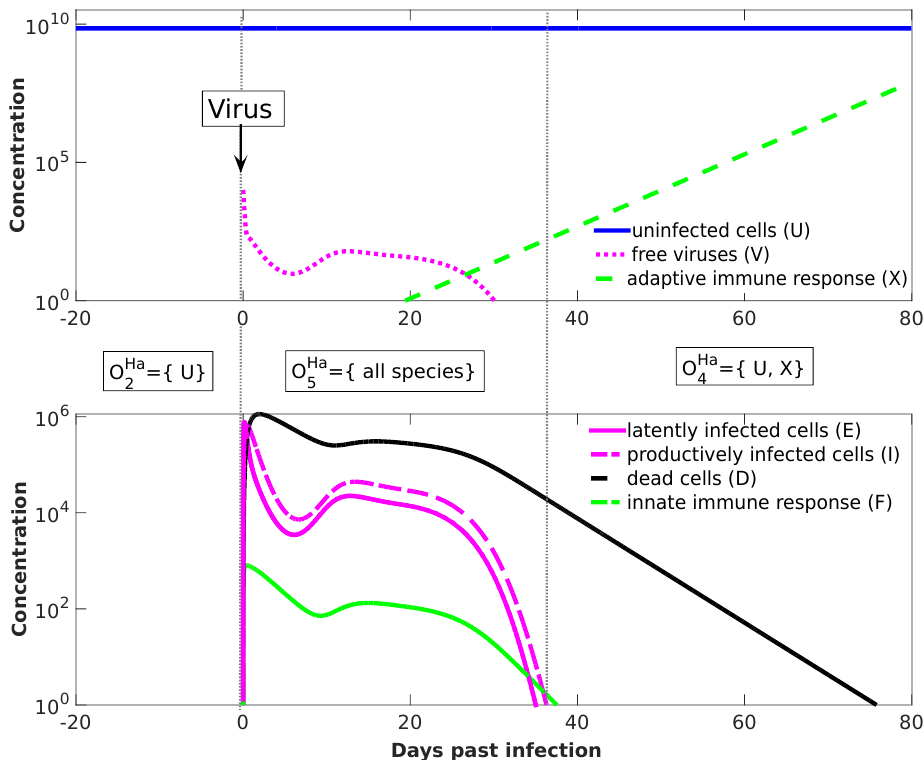
Figure 8. Temporal dynamics of the Handel model. By projecting the seven-dimensional trajectory to organizations (dotted arrows in Figure 7b) we find three phases: (Phase 1) Until day number 0, there are = { U } . (Phase 2) solely 7 × 10 9 uninfected cells U in the system represented by the organization O Ha 2 At day 0, infection is simulated by adding V ( 0 ) = 10 4 virus particles to the system. The resulting state { U , V } is projected to organization O Ha (all species). (Phase 3) Lastly, at day t = 37d past infection the 5 = { U , X } , which is generated by the set { U , X , D } system settles in the final organization, namely O Ha 4 (see text). The values of the model parameters are (from [24]): λ = 0.25, b = 2.1 × 10 − 7 , g = 4, d = 2, p = 5 × 10 − 2 , κ = 1.8 × 10 − 2 , c = 10, γ = 7.5 × 10 − 4 , k = 1.8, w = 1, δ = 0.4, f = 2.7 × 10 − 6 , and r = 0.3. Note that the number of uninfected cells U is not constant after infection as it may seem from the figure. In fact, after infection, the number of uninfected cells first decreases and than rises again